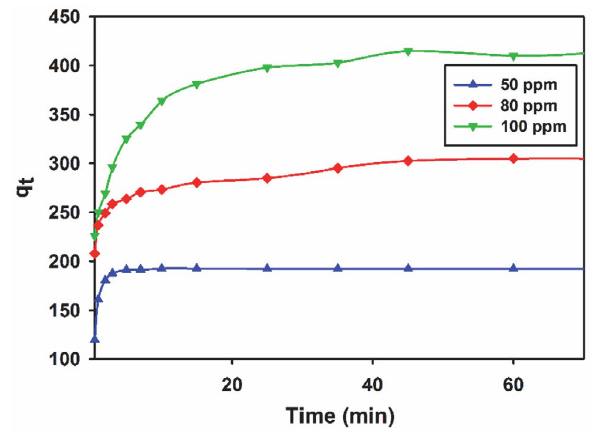
Figure 8. The effect of contact time on the bioreactor